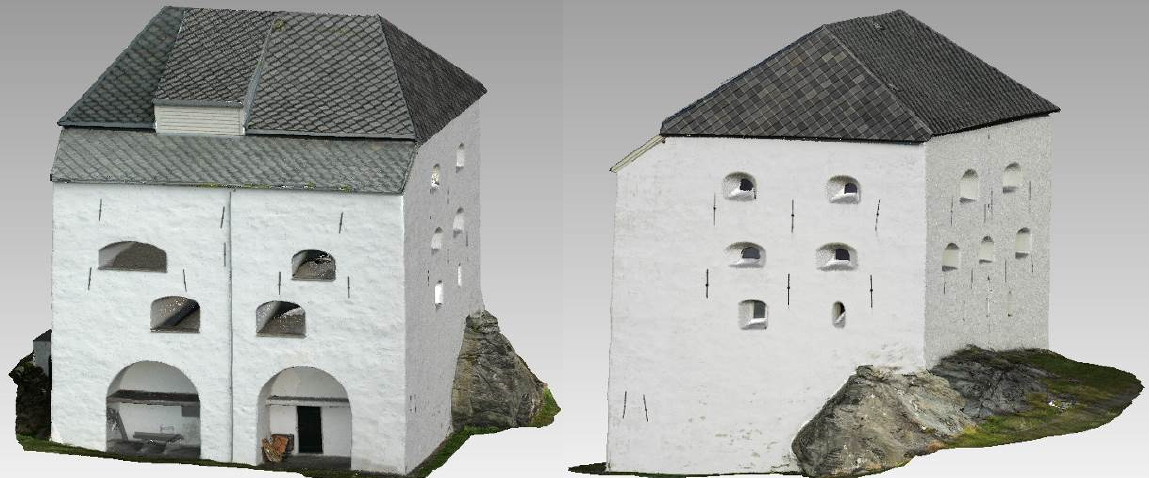
Figure 3: Perspective view of the defence tower (Donjon) modelled from point clouds – manual texture mapping on meshes in